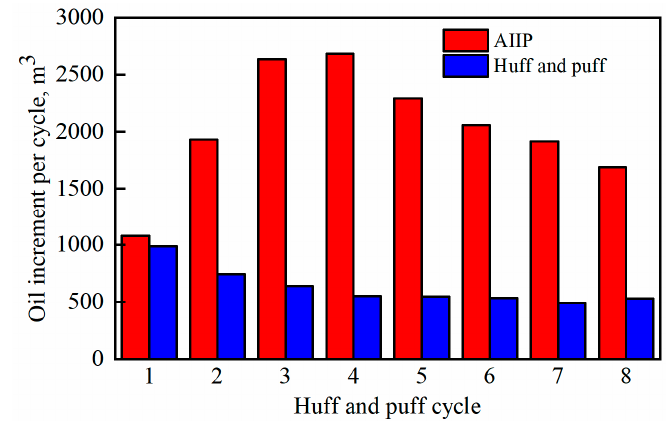
Figure 7. Average formation pressure variation in the production process.